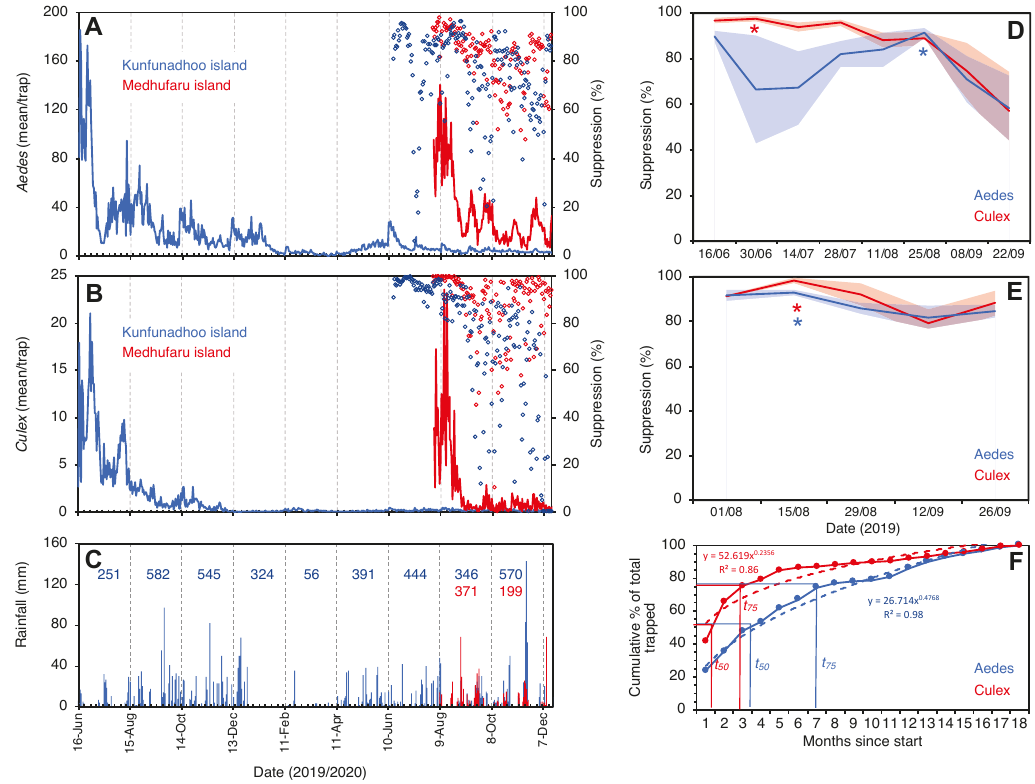
Figure 5. Trap catches of Ae. albopictus ( A ) and Cx. quinquefasciatus ( B ) mosquitoes in Kunfunadhoo (blue line) and Medhufaru (red line) islands, Maldives, between June 2019 and December 2020. Open blue circles in both graphs show the percentage suppression of mosquito populations compared to the same date one year previously. Open red circles show the percentage suppression on Kunfunadhoo island compared to Medhufaru island. ( C ): Actual rainfall (bars) and cumulative rainfall over two-month periods (numbers) for Kunfunadhoo (blue) and Medhufaru island (red). ( D ): Level of suppression (percentage ± 95% CI) compared to one year previously (asterisks (*) show highest level recorded for Aedes (red) and Culex (blue) mosquitoes). ( E ): Similar, but between-island comparison of suppression levels. ( F ): Cumulative percentage of mosquitoes removed from Kunfunadhoo island over the entire 18-month period, showing the time needed to trap 50% ( t 50 ) or 75% ( t 75 ) of all mosquitoes collected for both